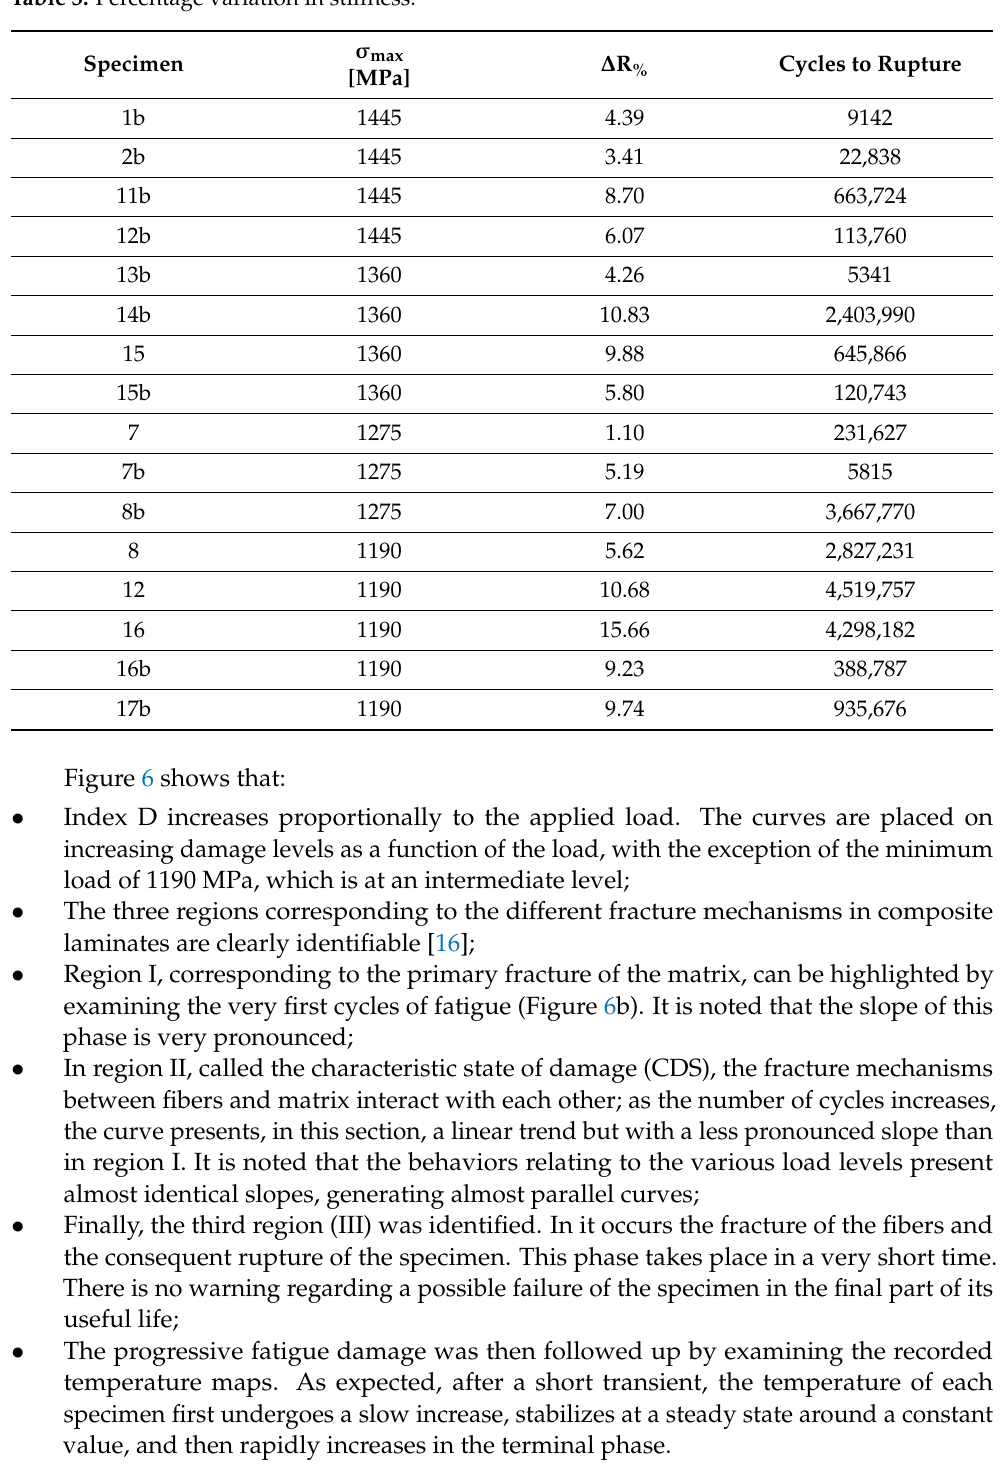
Table 3. Percentage variation in